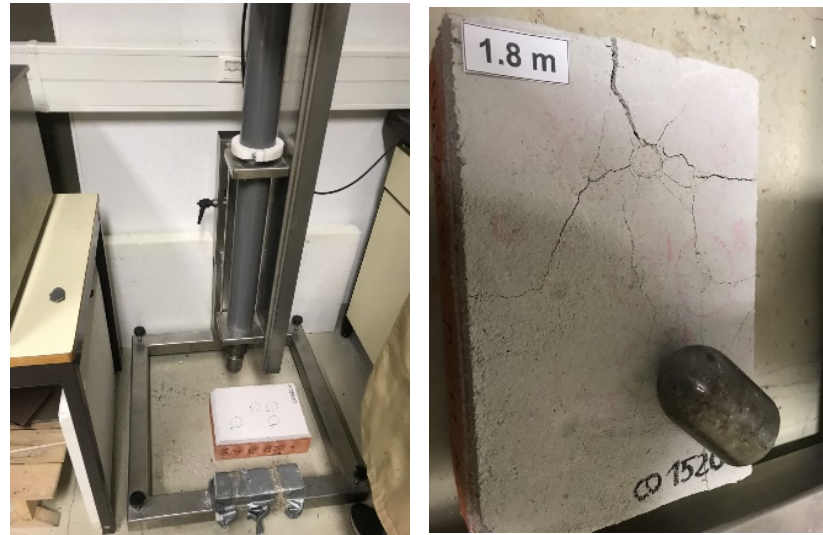
Figure 3. Illustration of the impact test.